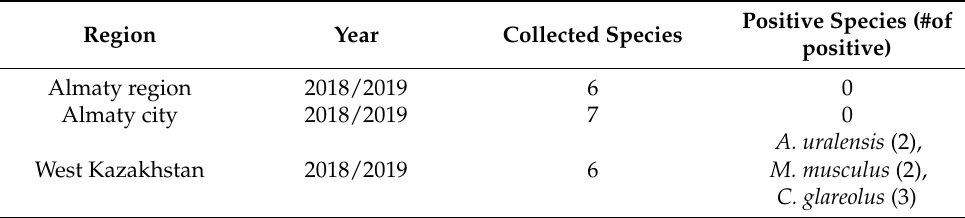
Table 2. Results of OHFV real-time RT-PCR screen in lung tissue of small mammals ( n = 621) from Almaty region (three trapping sites), Almaty city (seven trapping sites) and West Kazakhstan (19 trapping sites) from 2018/2019. In total, eleven species were collected. Region Year Collected